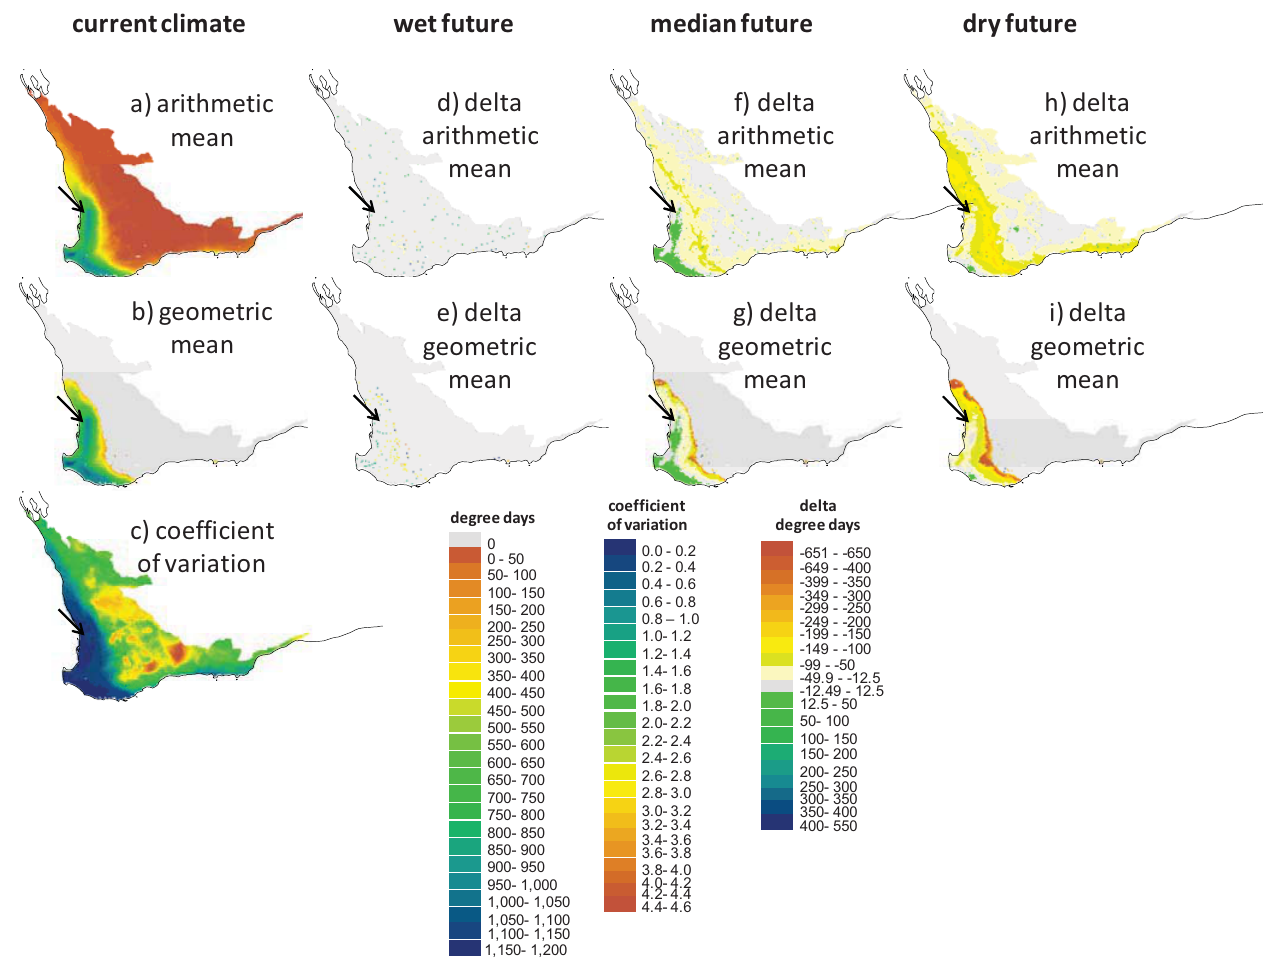
Figure 8. Screening maps of the output of NicheMapR coupled with WET-R showing ( a ), the arithmetic mean, ( b ) the geometric mean and ( c ) the coefficient of variation of the degree days above 14 °C, assuming the tortoises spend virtually all of the hydroperiod basking ( i.e. , foraging bouts are only a small fraction of each simulated hour). The degree day metric is proportional to the potential for feeding and assimilation . Models are driven by current climate (1990–2009: AWAP data, a – c ) and also indicated are the impacts of the three future climates for 2030 outlined in Figure 4 (future scenario—current scenario; d – i ). The black arrow indicates the location of the wild